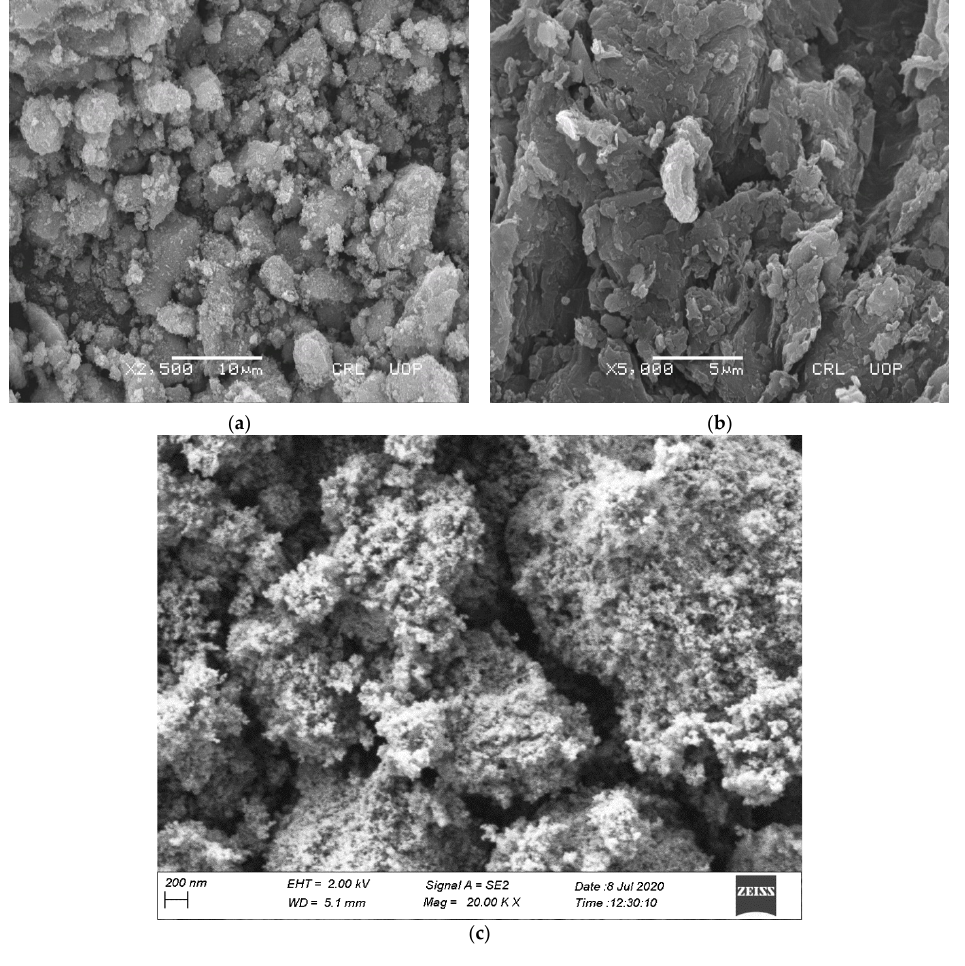
Figure 3. Scanning electron microscope (SEM) images of ( a ) GO, ( b ) MnO 2 /MrGO, and ( c ) field emission scanning electron microscope (FESEM) image of MnO 2 /MrGO .